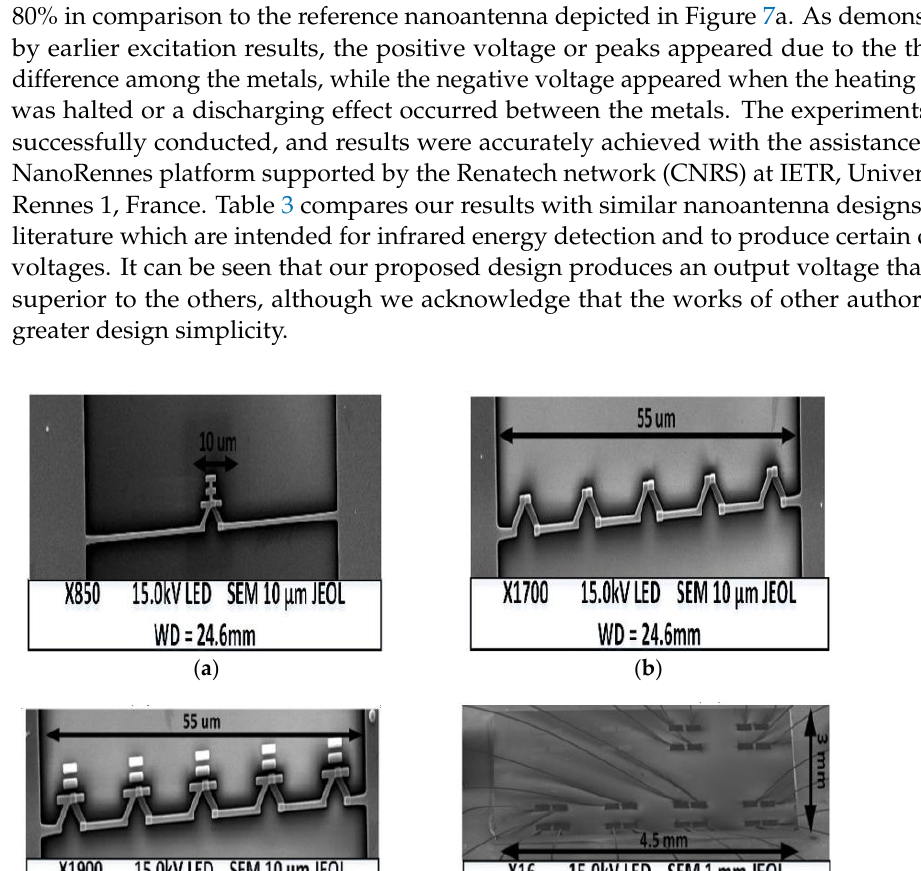
Figure 12. Measurement: excitation of the three designs with a 1550-nm laser. Table 2. Comparison of the peak percentage voltage hikes shown in Figure 12 when excited with a 1550-nm laser source.